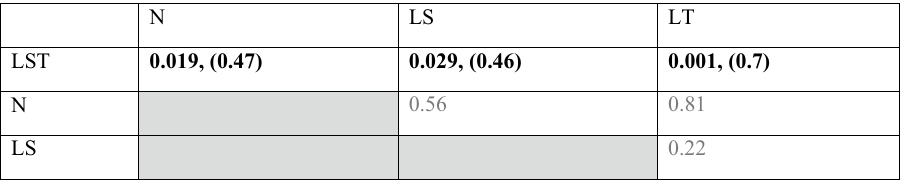
Table 2. Permutation test statistics of the slope parameter between conditions. Listed are p values and Cohen’s d for significant p values in parentheses. Significant p values (alpha = 0.05, with Bonferroni-Holm correction) and effect sizes in